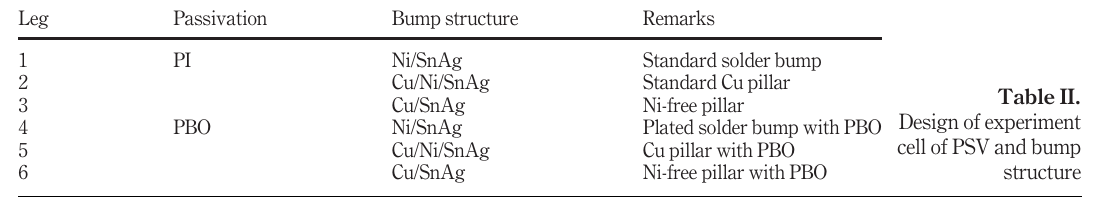
Table II. Design of experiment